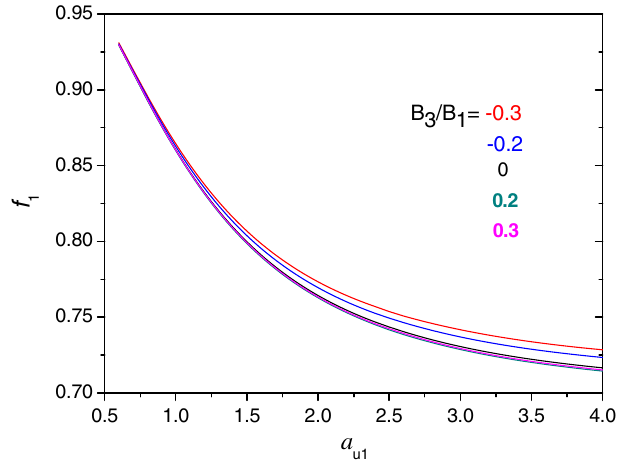
FIG. 2. Modified fundamental coupling coefficient due to the harmonic magnetic